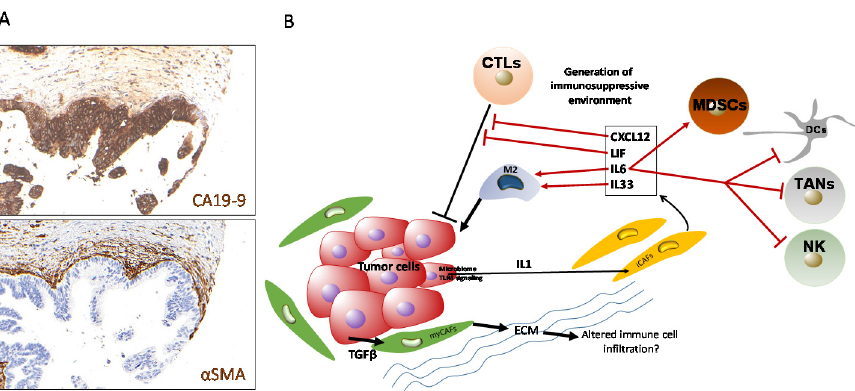
Figure 5. The functions of CAFs in the immune landscape of PDAC. ( A ) Immunohistochemical example of tumor cell localization (CA19-9 staining in brown, upper panel) and α SMA-positive myCAFs (also brown, lower panel) in human PDAC. Note that the myCAFs are in close vicinity to the tumor cells. ( B ) Tumor cells polarize quiescent pancreatic stellate cells towards different subtypes of cancer-associated fibroblasts (CAFs). Contractile myCAFs and inflammatory-CAFs (iCAFs) represent the two major populations. IL1-induced iCAFs secrete a large number of soluble mediators that affect a plethora of immune cells, essentially generating an immunosuppressive environment favoring tumor cell growth. In addition, immune cells might also be suppressed by CAF-mediated metabolic competition and direct cell-cell contact (not shown).